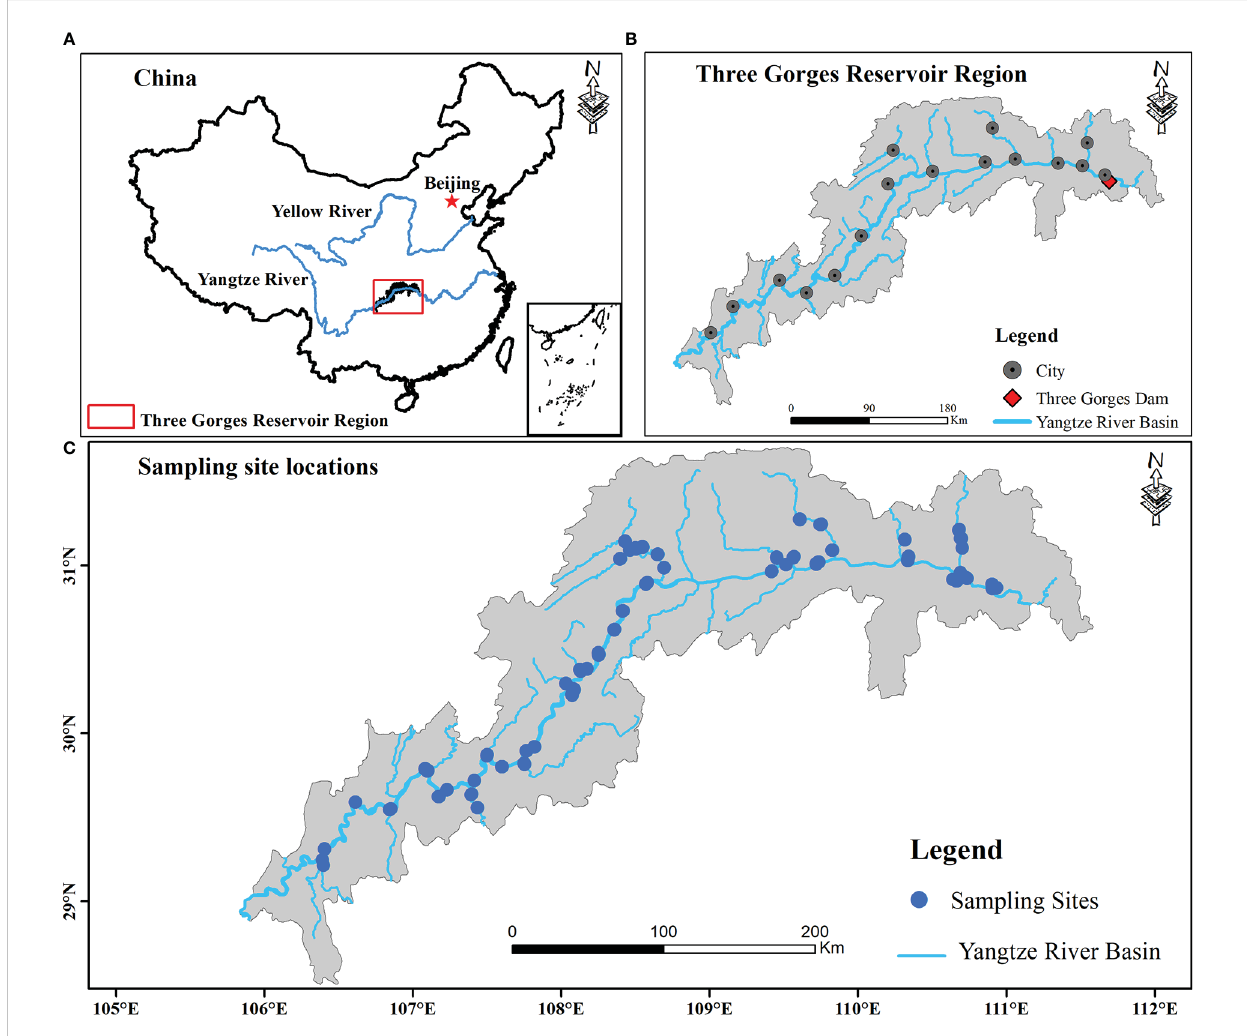
FIGURE 1 Location of study regions and sampling sites (B, C) within the reservoir riparian zone regulated by the Three Gorges Dam on the Yangtze River in China (A)